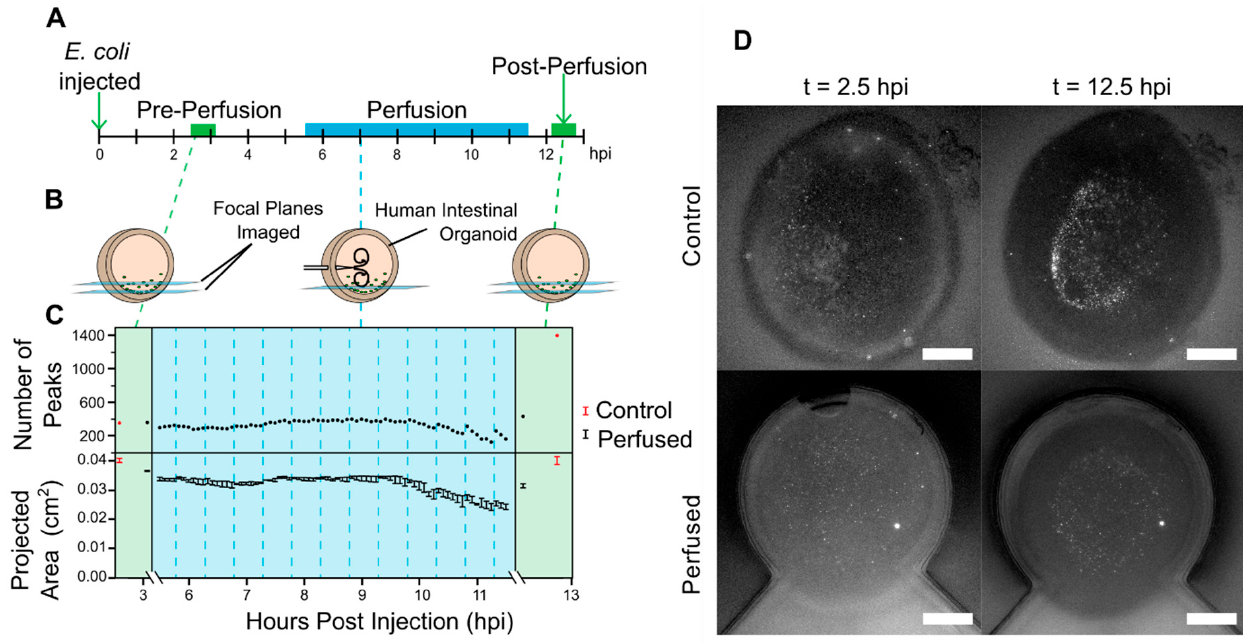
Figure 4. ( A ) A timeline for the perfusion experiment is shown. ( B ) Before and after the experiment, multiple focal planes were flattened to identify a maximal number of bacteria. During the perfusion period, only a single focal plane was used and kept at a constant height. The plotted data is for one HIO. ( C ) The number of peaks and projected area are shown with time. Single measurements are plotted as dots for number of peaks, and ± 1 standard deviation for three area measurements is plotted for the projected area. Note: the first perfusion cycle is not included. Fluorescence imaging began 10 min after the first perfusion sequence. ( D ) Photos from before and after the experiment display settling for both the control and perfused HIOs. Scale bars: 500 µm.